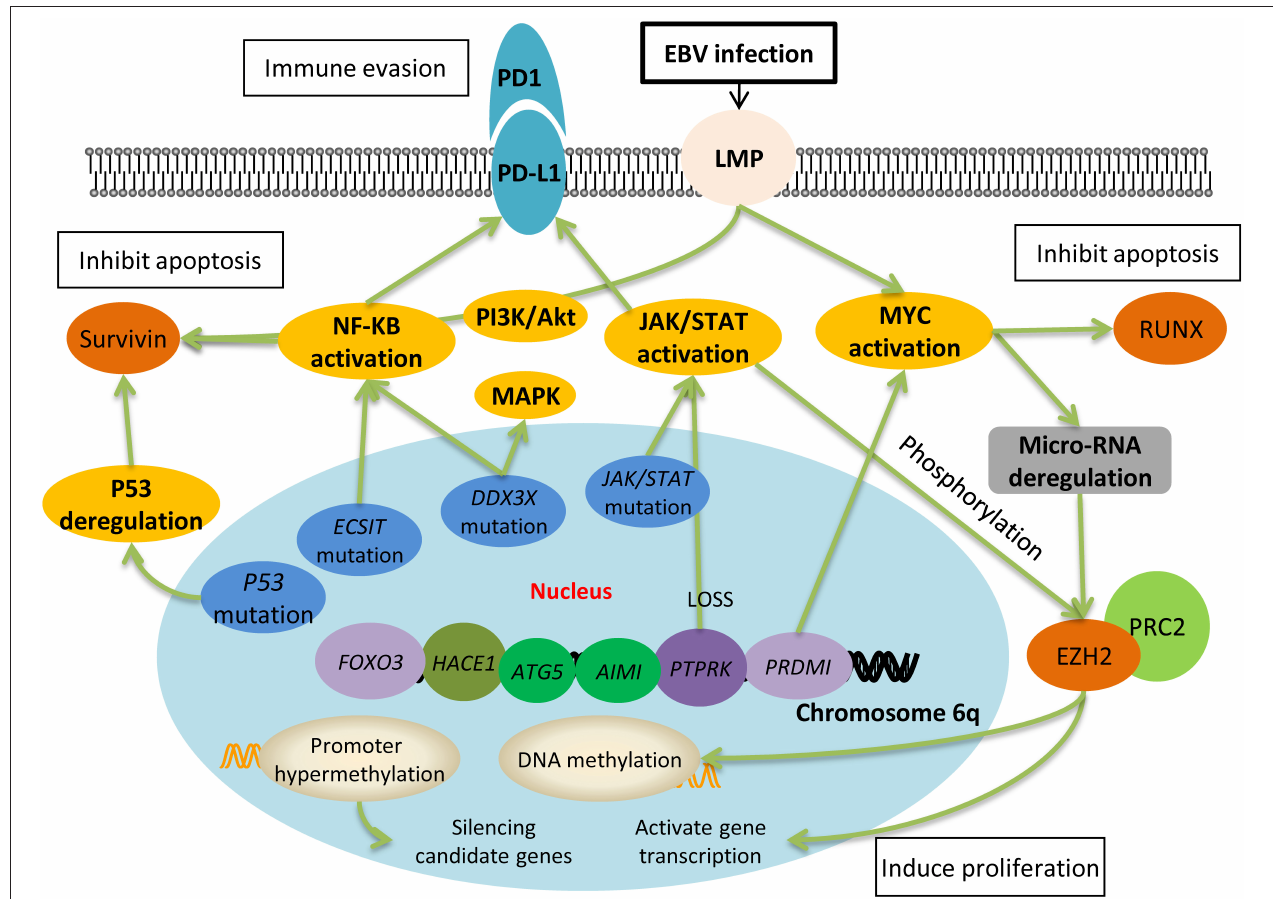
FIGURE 1 | Molecular pathogenesis of Epstein-Barr virus-positive NK/T-cell lymphoma. EBV latent membrane protein-1 (LMP-1) activates the downstream signaling pathways, one of which is the NF- κ B pathway. Together with PI3K/Akt pathways, NF- κ B leads to the upregulation of survivin, which further inhibits cell apoptosis. Activation of JAK/STAT is associated with the upregulation of EZH2, which results in DNA methylation and gene transcription, and ultimately induces cell proliferation. Both the NF- κ B pathway and JAK/STAT pathway upregulates the expression of PD-L1 on the surface of lymphoma cells and they escape from the immune surveillance of activated T cells. The deletion of chromosome 6q silences many tumor suppressor genes, such as PTPRK and PRDMI , which directly result in the activation of JAK/STAT and myc pathways. Moreover, gene mutation including P53, ECSIT , DDX3X are also involved in the oncogenesis of ENKL through the pathways mentioned